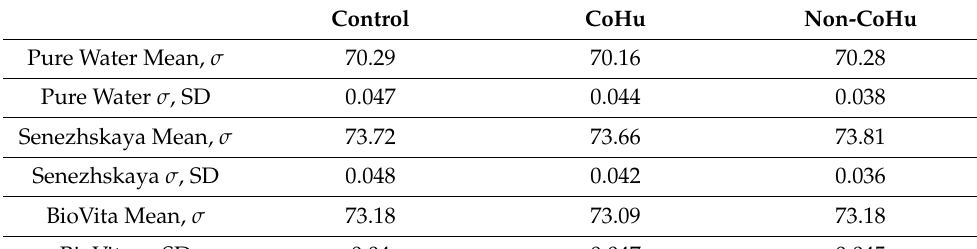
Table 1. Mean surface tension and standard deviation of the mean in pure water, Senezhskaya and